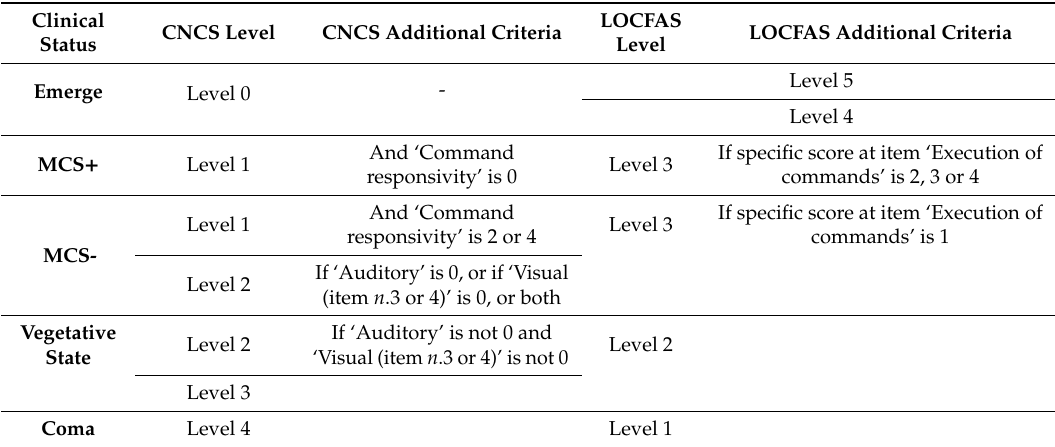
Table 1. Framework for theoretical association between clinical status and CNCS and LOCFAS levels. MCS: minimally conscious